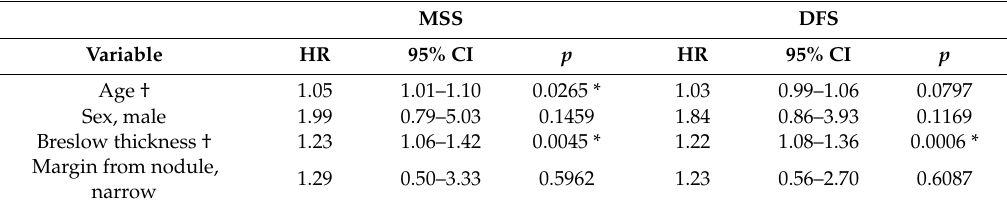
Table 7. Cox multivariate analysis on the prognostic impact of narrow-margin excision from nodule. MSS